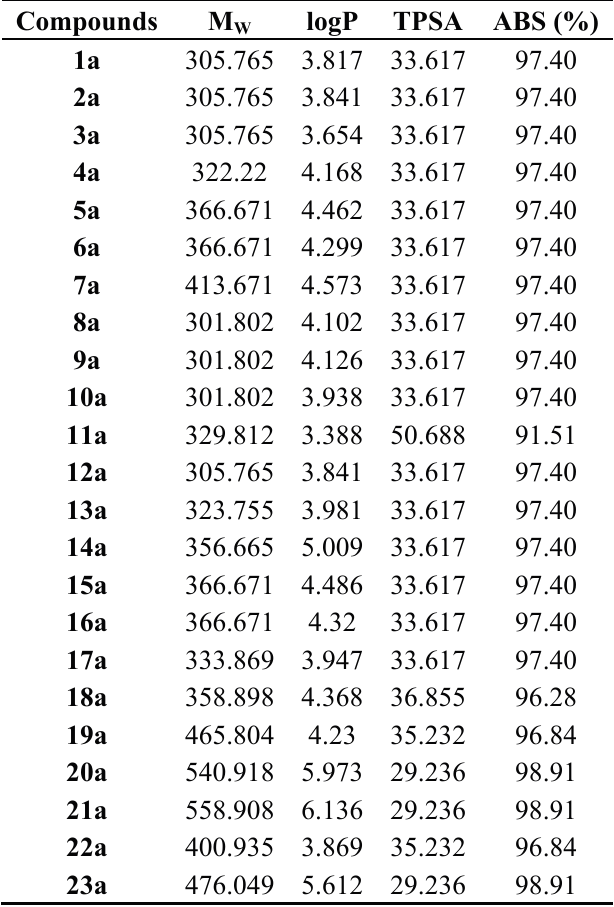
Table 3. Physicochemical parameters of the studied